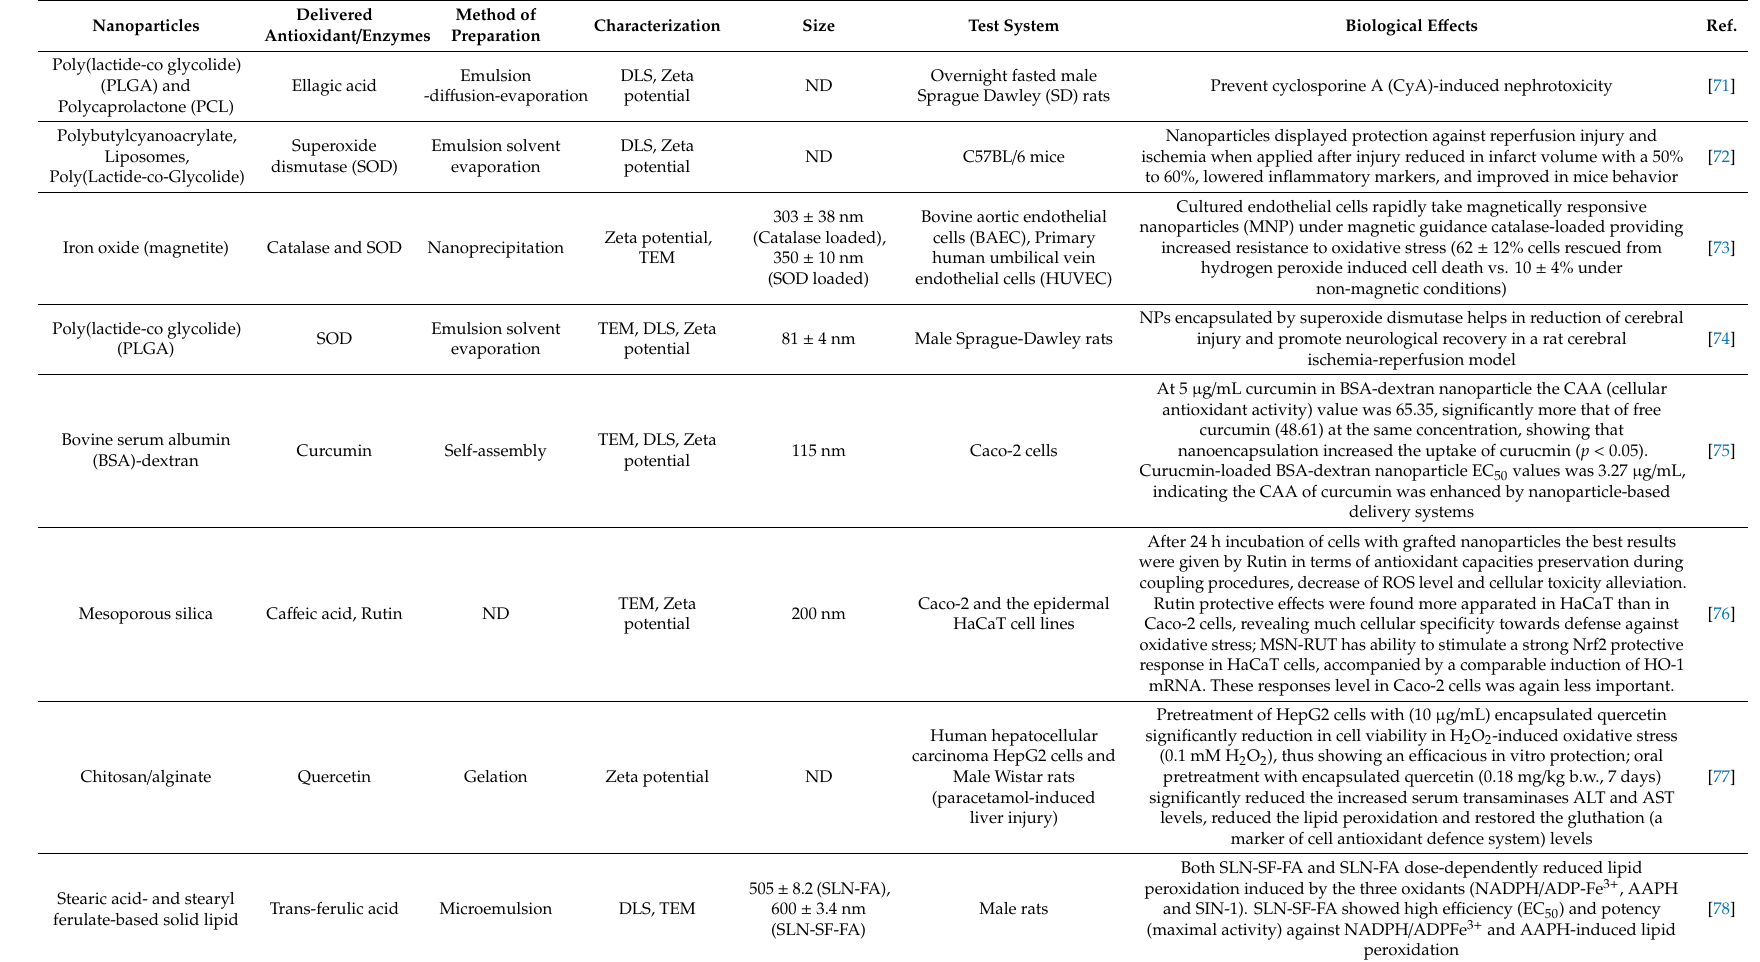
Table 2. In vivo and in vitro delivery of antioxidants by di ff erent